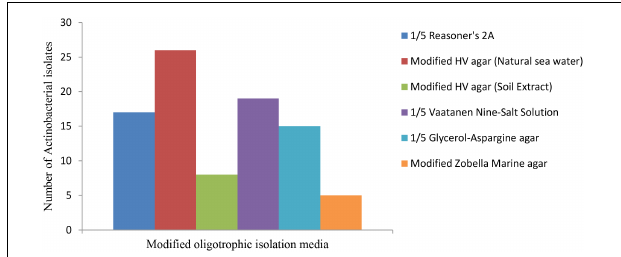
FIGURE 2 | Comparison of the isolation media versus the number of recovered strains. Modified HV medium containing artificial seawater supported the highest number and diversity of the